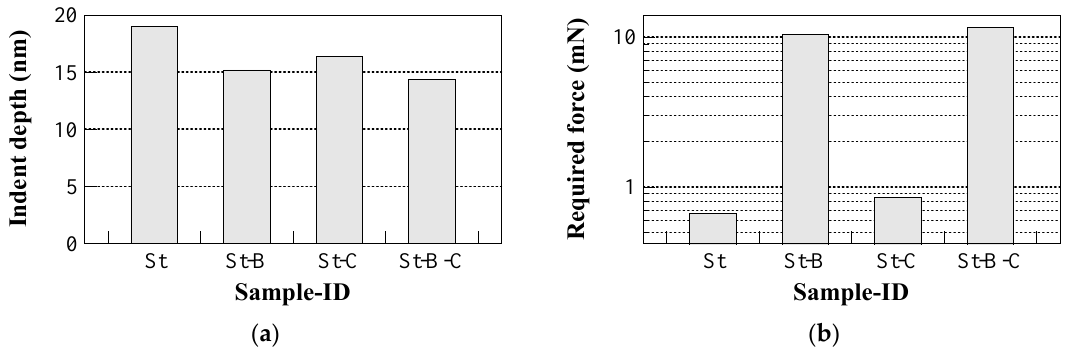
Figure 6. FEA modeling results of nanoindentation for ( a ) a constant applied force and the resulting deformation along the depth, and ( b ) a constant deformation along the depth and the corresponding force for all samples.